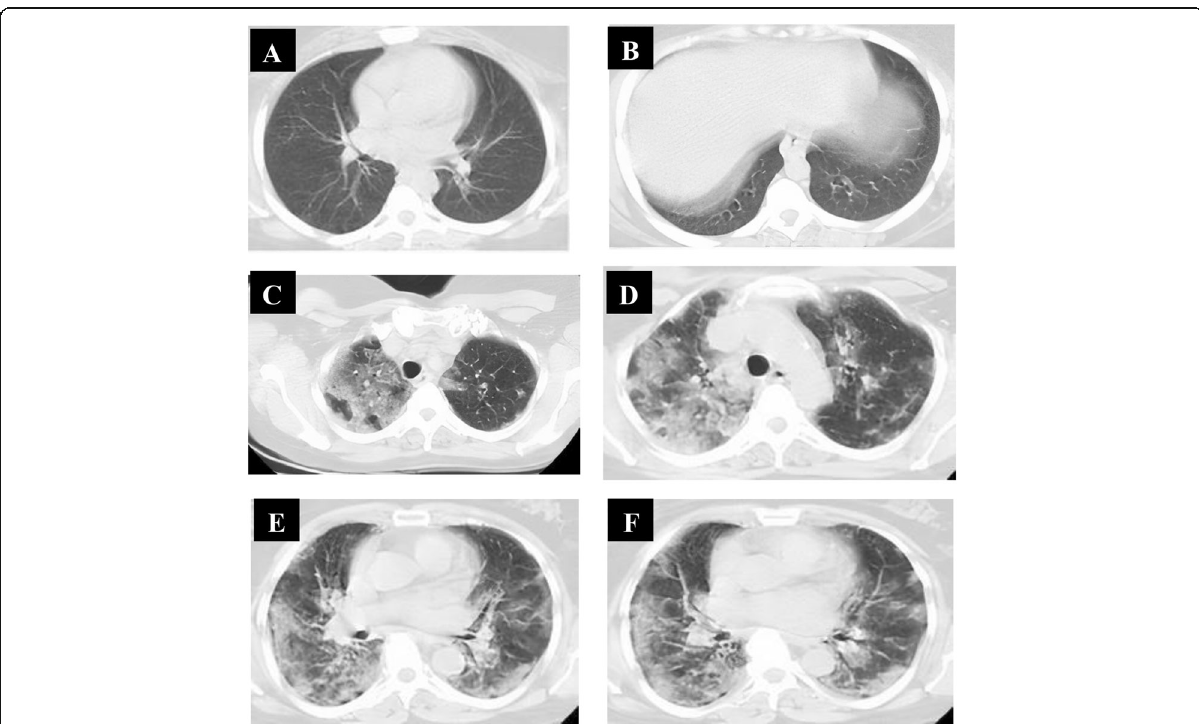
Fig. 4 A 33-year-old male patient complaining of fever, sore throat, and cough (mild symptoms). Non-contrast axial chest CT ( a , b ) 2 days after onset of symptoms (early phase) revealed two patchy areas of consolidation seen at the right lung middle and lower lobes with air bronchogram and left-sided pleural effusion. With the persistence of the same symptoms (no respiratory distress), follow-up chest CT ( c – f ) 7 days from the onset of symptoms revealed more extensive lesions in the form of multiple confluent patchy areas of ground-glass opacities, consolidation, and crazy-paving seen scattered at both lungs: central and peripheral in distribution and bilateral minimal pleural